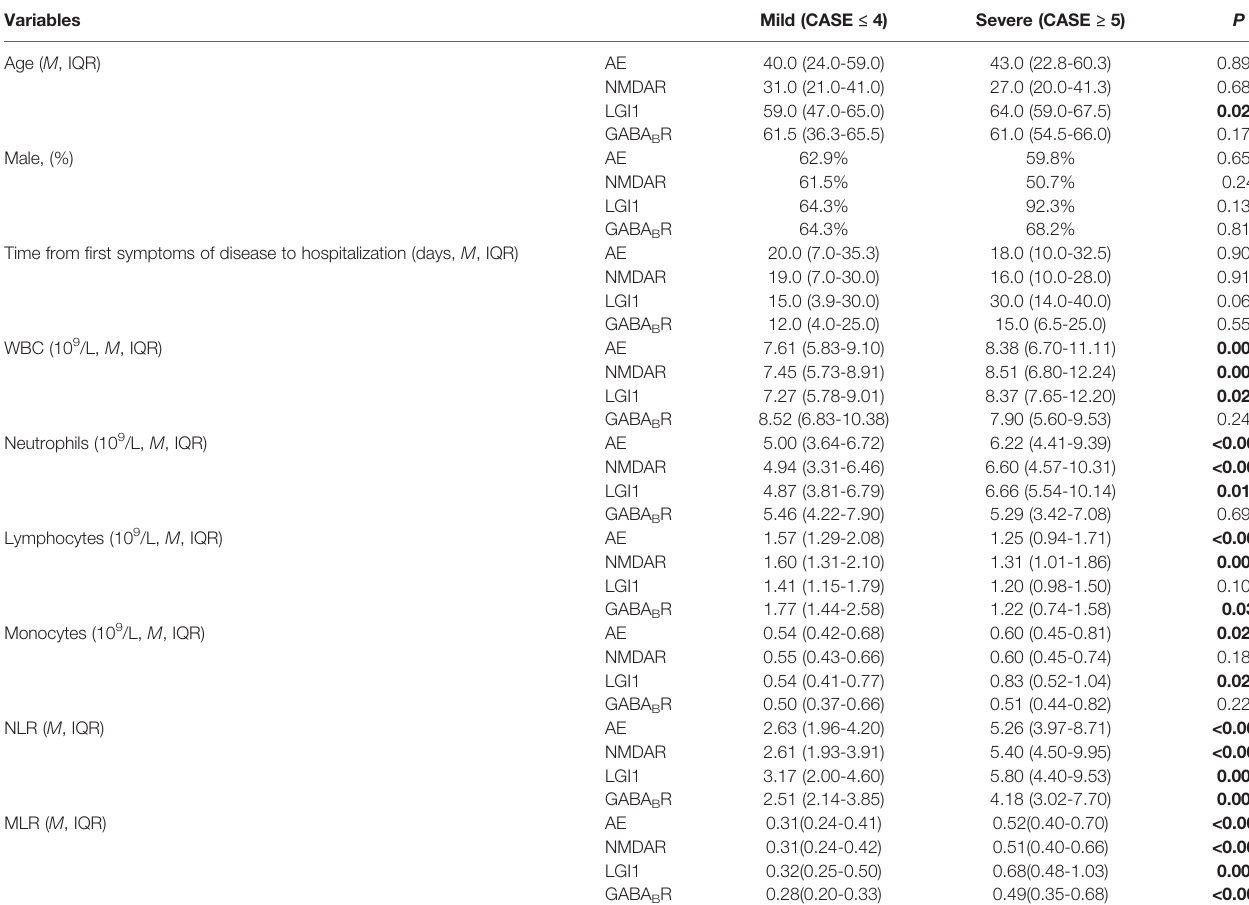
TABLE 2 | Comparisons of clinical data between mild and severe patients.